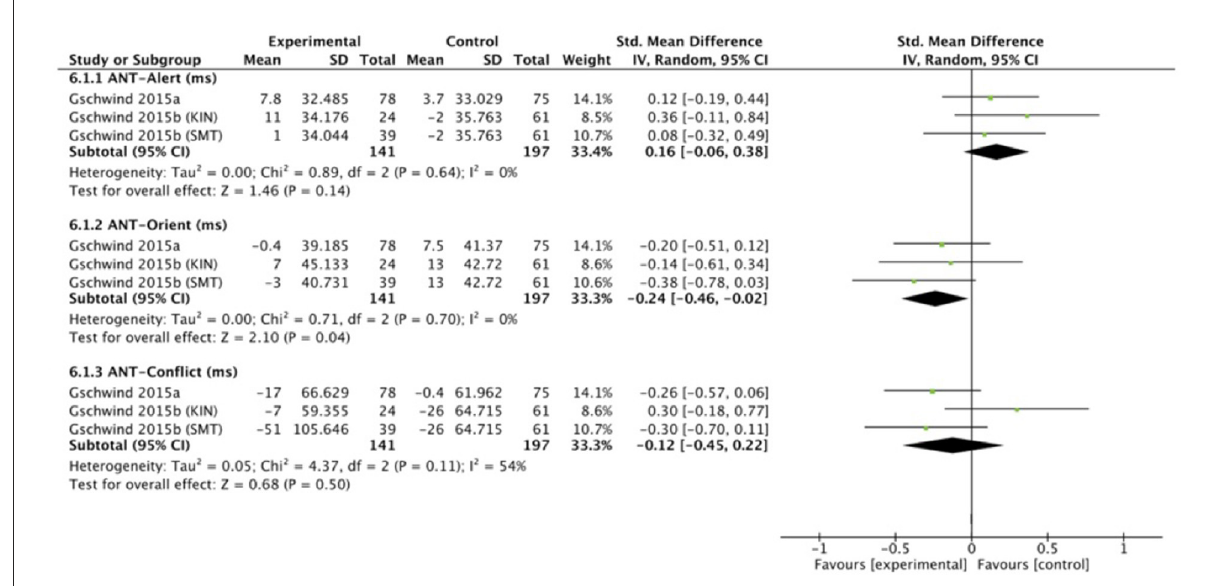
FIGURE9 Random effects meta-analysis forest plot for effectiveness of intervention on measures of ANT cognitive performance outcomes.